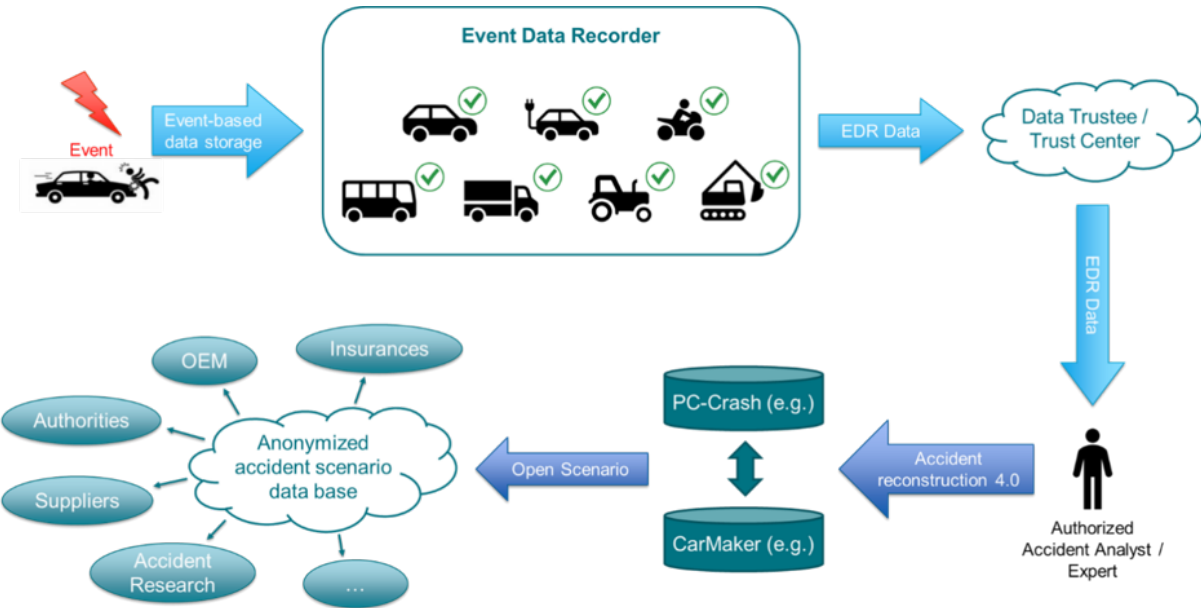
Figure 4: Overall concept for an accident analysis of the